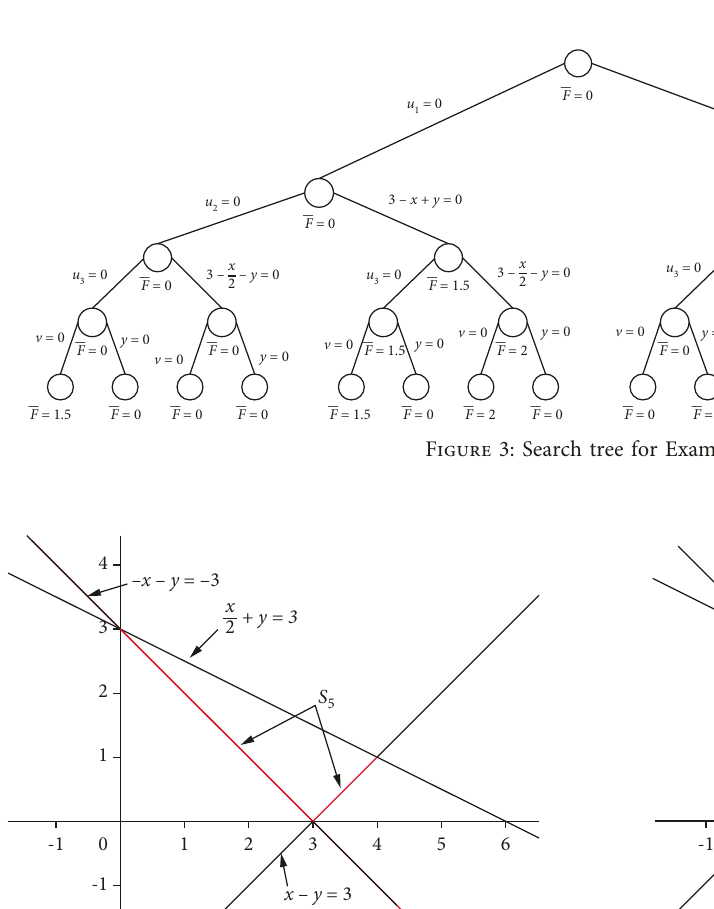
Figure 5: Feasible set of BL